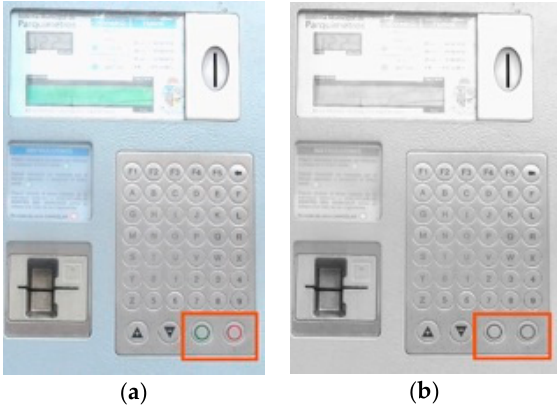
Figure 19. San Pedro Garza García’s parking meter interface. On the left side ( a ), the buttons’ colors are obvious for a person with color vision; on the right ( b ) a person with color vision defect cannot identify actions.